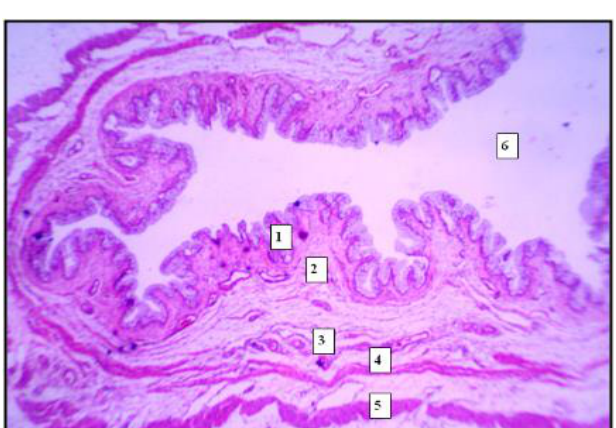
Figure 7. Vagina at its middle region showing short mucosal folds (1), propria- submucosa (2& 3), internal circular layer of tunica muscularis (4), external longitudinal layer of tunica muscularis (5), vaginal lumen (6). 40X, H&E